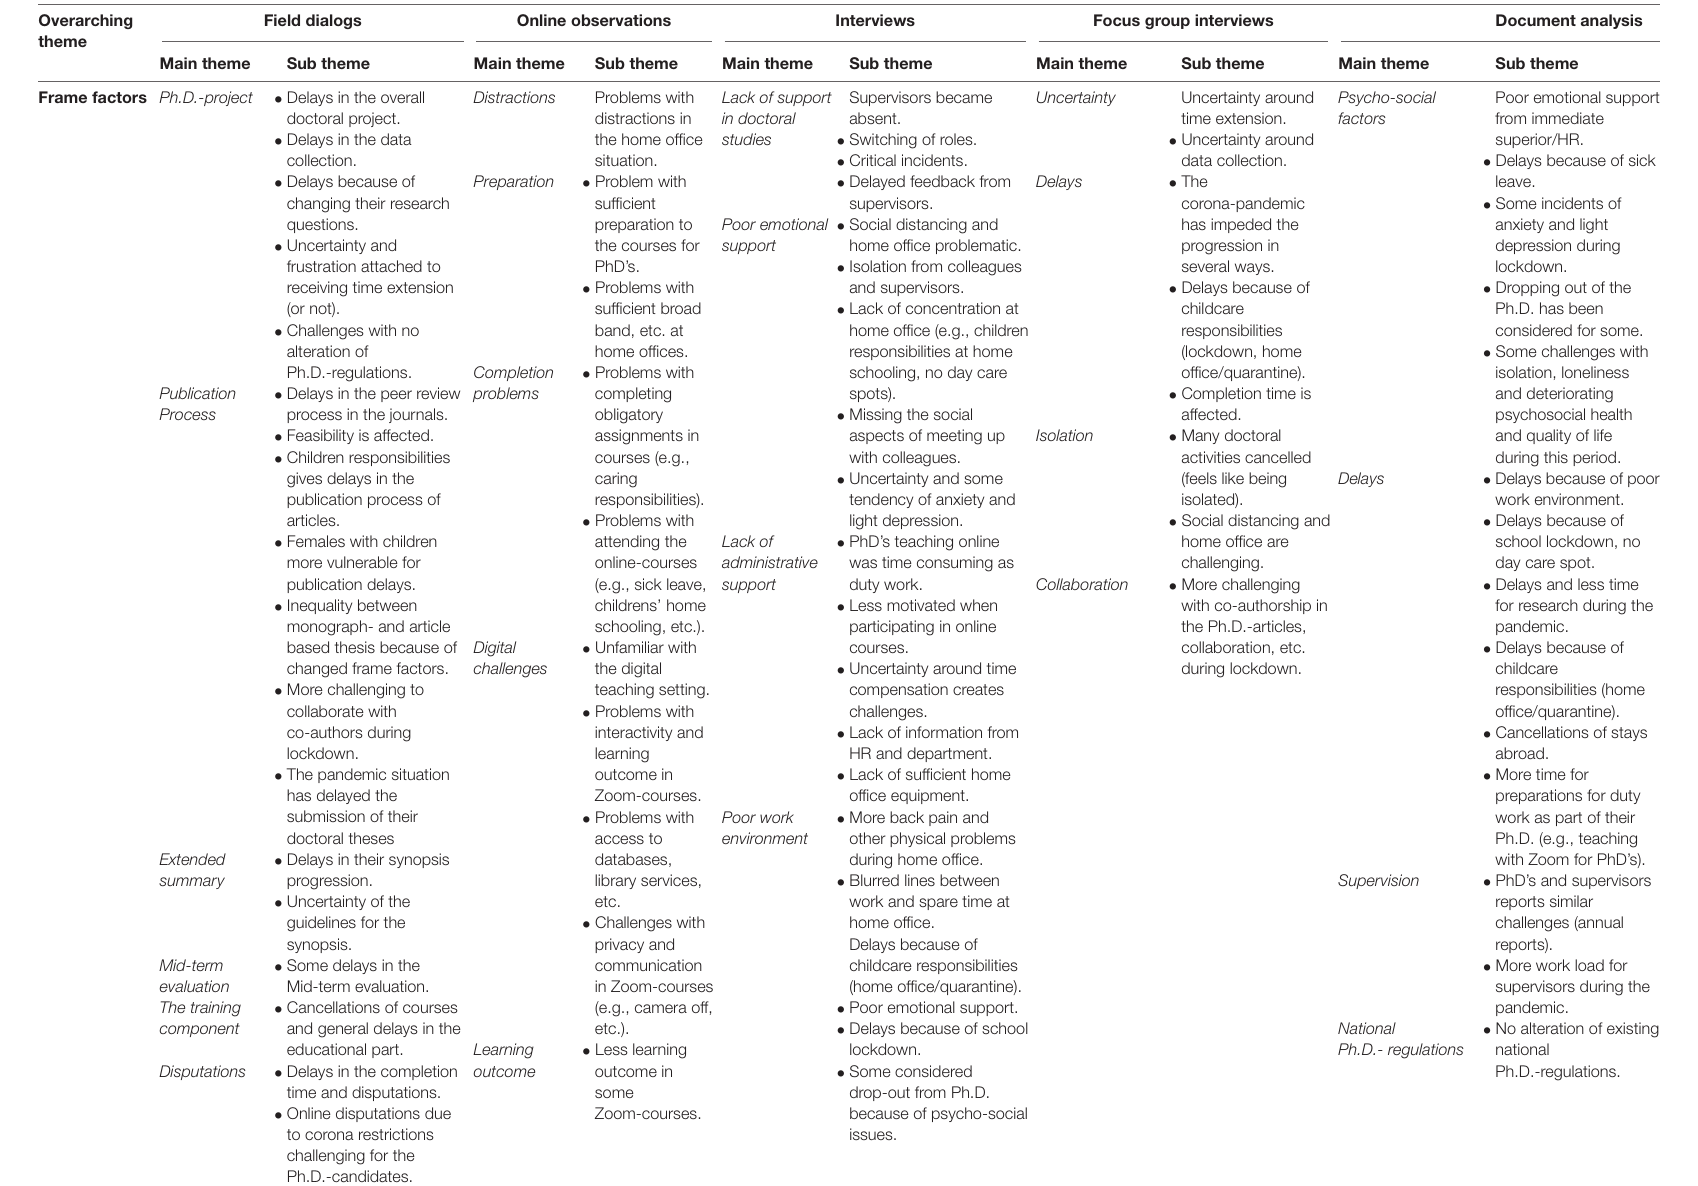
TABLE 5 | Overview of themes across the sources of data. Overarching